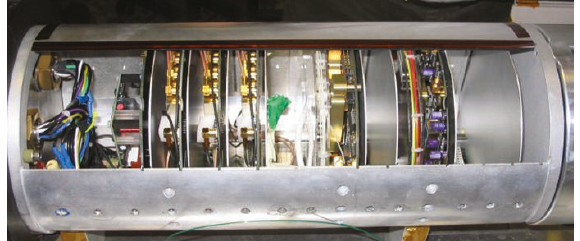
Figure 4: An LCM crate equipped with AcouADC boards before insertion into its titanium housing. From the left to the right, the following boards are installed. The Compass board, 3 AcouADC boards, a Data Acquisition (DAQ) board that sends the data to shore, and a Clock board that provides the timing signals to correlate measurements performed in di ff erent